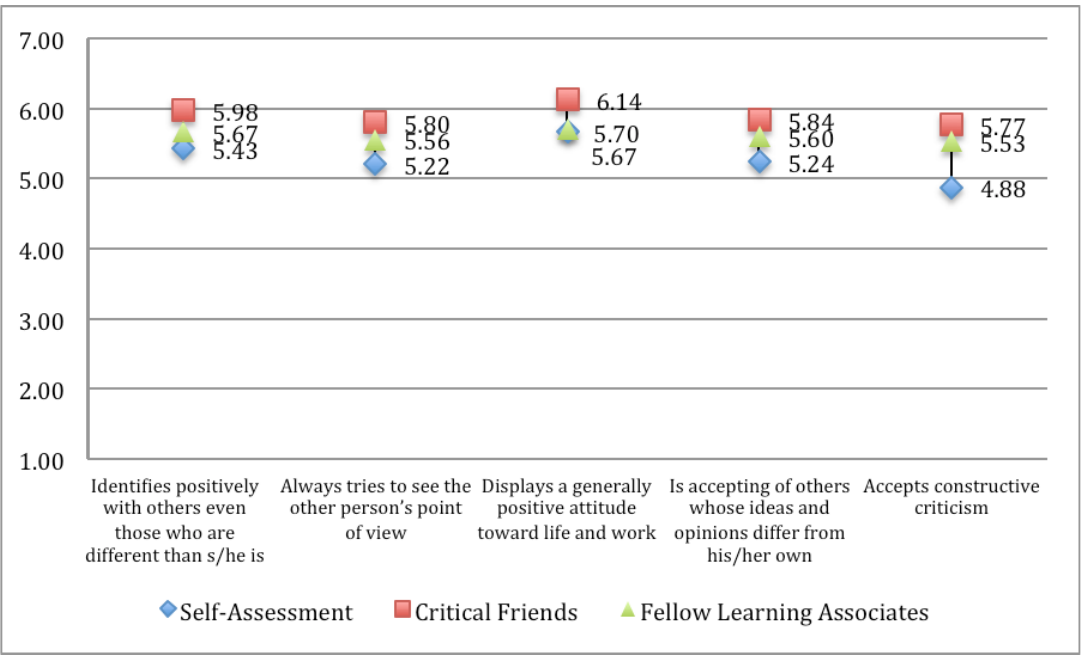
Figure 4. Perceptions of Self. Self-Assessment N=74, Critical Friends N=573, Fellow Learning Associates